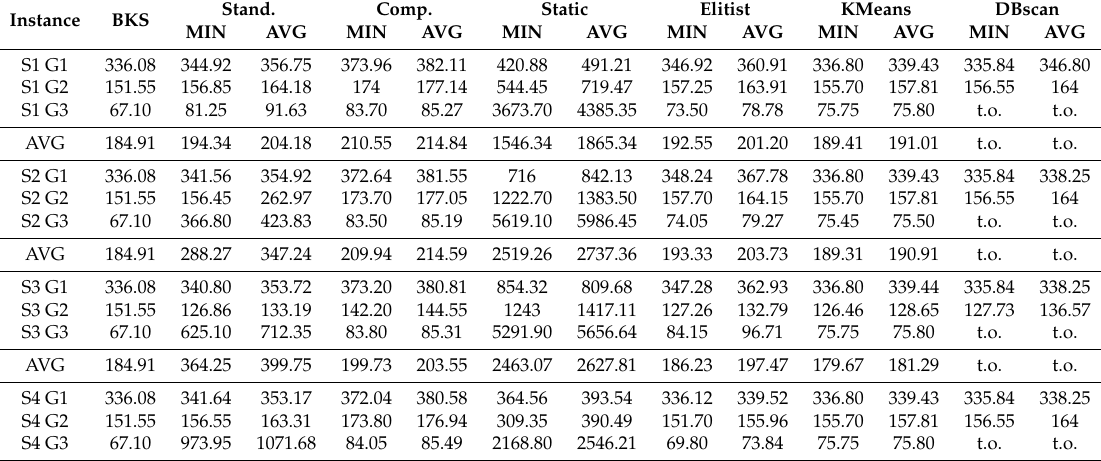
Table 6. CSA/SCP—Two-steps vs. KMeans vs. DBscan resume summary (t.o = time